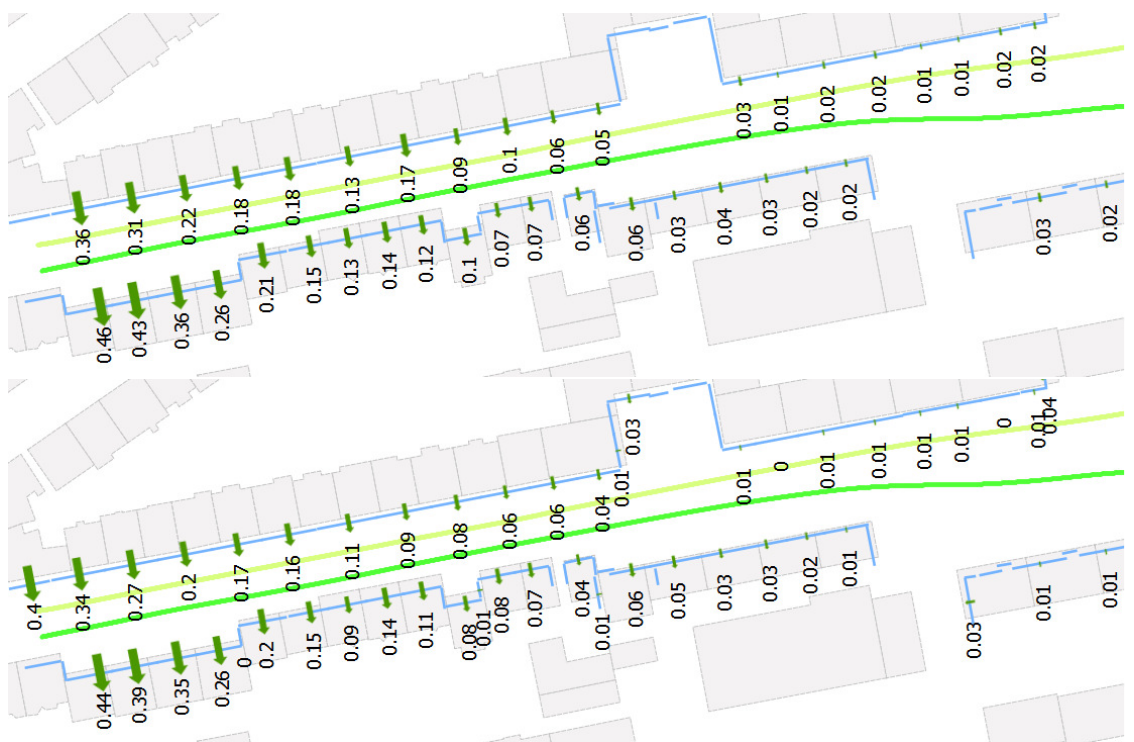
Figure 18. A comparison of the initial and optimized facade errors in the Dortmund 2 dataset. The box plots show the average (black line), the maximal error (whisker) and one standard deviation above and below the datum (box). We summarize each combination of sensor/pass in the same sequence as in Figure 17, i.e. , left sensors for the first and second pass (L1–L2), left sensor for the first pass and right sensor for the second pass (L1–R2), and so on. In addition, the overall errors (all) are plotted, as